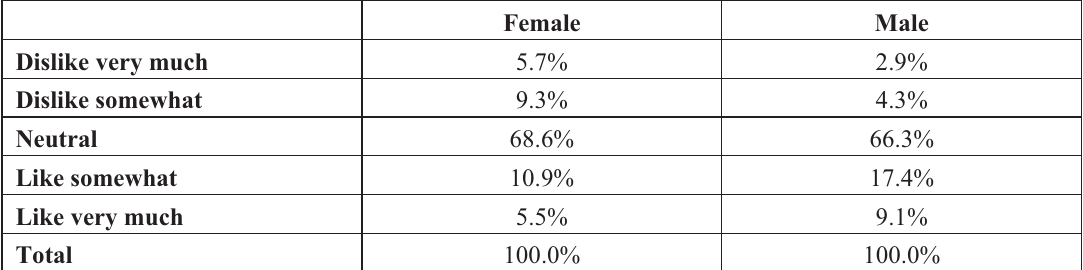
Table 15. The relationship between gender and how much the respondents liked or disliked coyotes. Results of a Chi-square test for